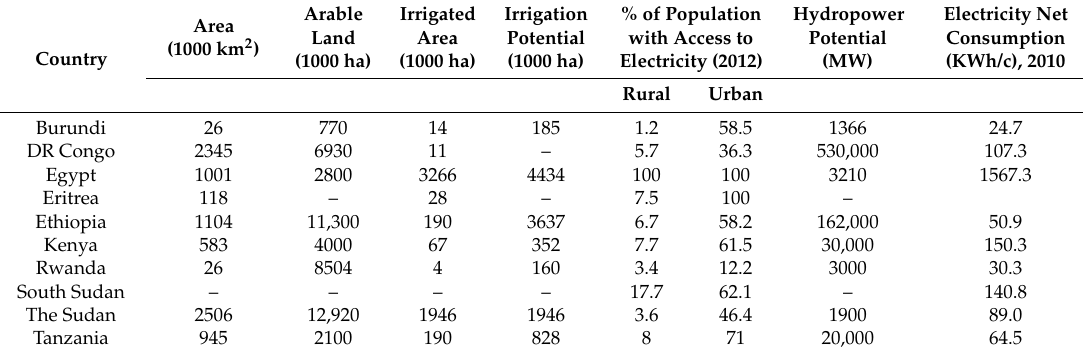
Table 5. Nile Basin data on land, irrigation, and hydropower (area per country, access to arable land, irrigated area, irrigation potential, the percentage of the rural and urban population with access to electricity, hydropower potential, and hydropower installed). Source: NBI (2016) for the 2012 access to access to electricity (% of the population) in urban and rural areas and the electricity net consumption (KWh/c), 2010 ([24], pp. 62–63). NBI (2012) for the 2008 data on access to water